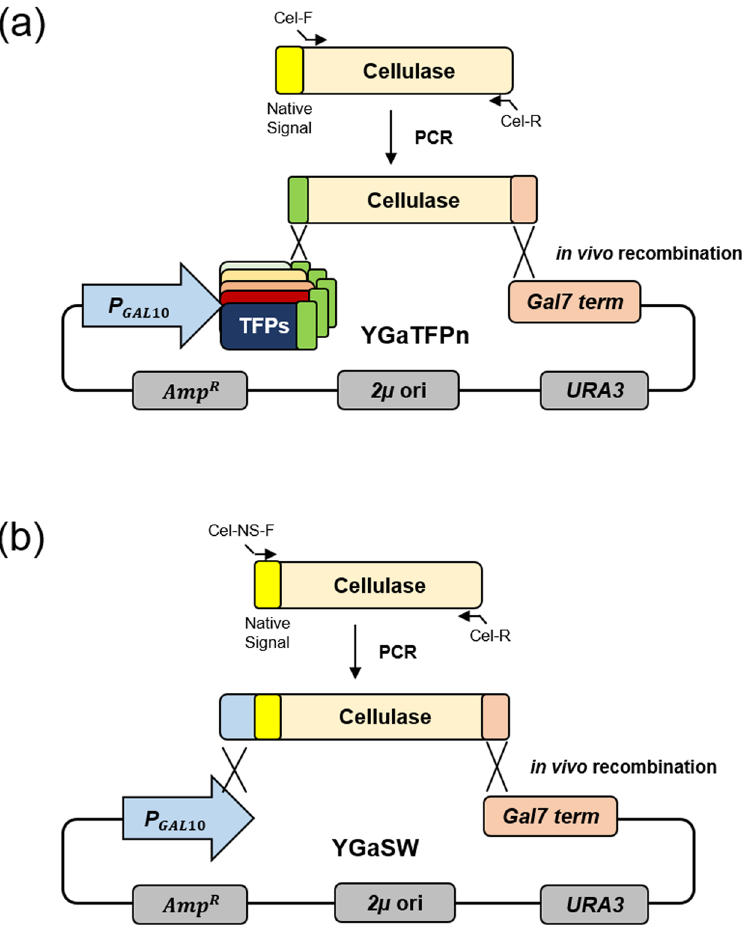
Figure 2. Diagram for vector construction by in vivo recombination for screening an optimal secretion signal. ( a ) The cellulase genes were flanked with the linker and terminator fragment by PCR with the primers Cel-F/ Cel-R and transformed with the 24 Swa I-linearized TFP vectors. ( b ) For secretion of the cellulases with their native signal sequences, amplified cellulase genes containing the signal sequence were integrated into the Swa I- digested YGaSW vector by in vivo